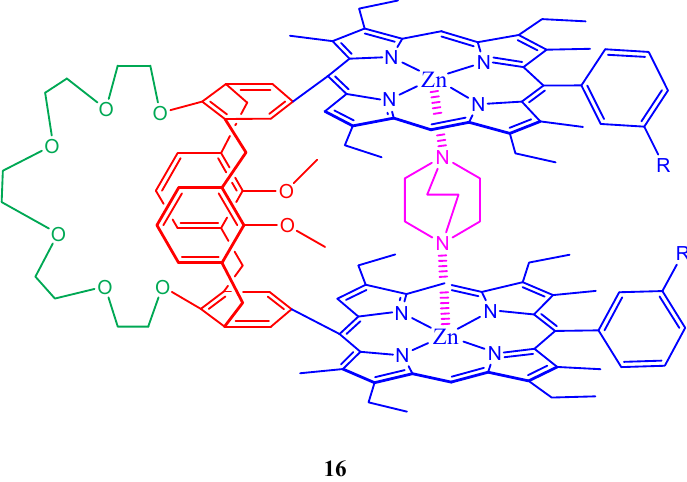
Figure 17. The heterotopic receptors based on bisporphyrin-calix[4]arene crown ether.